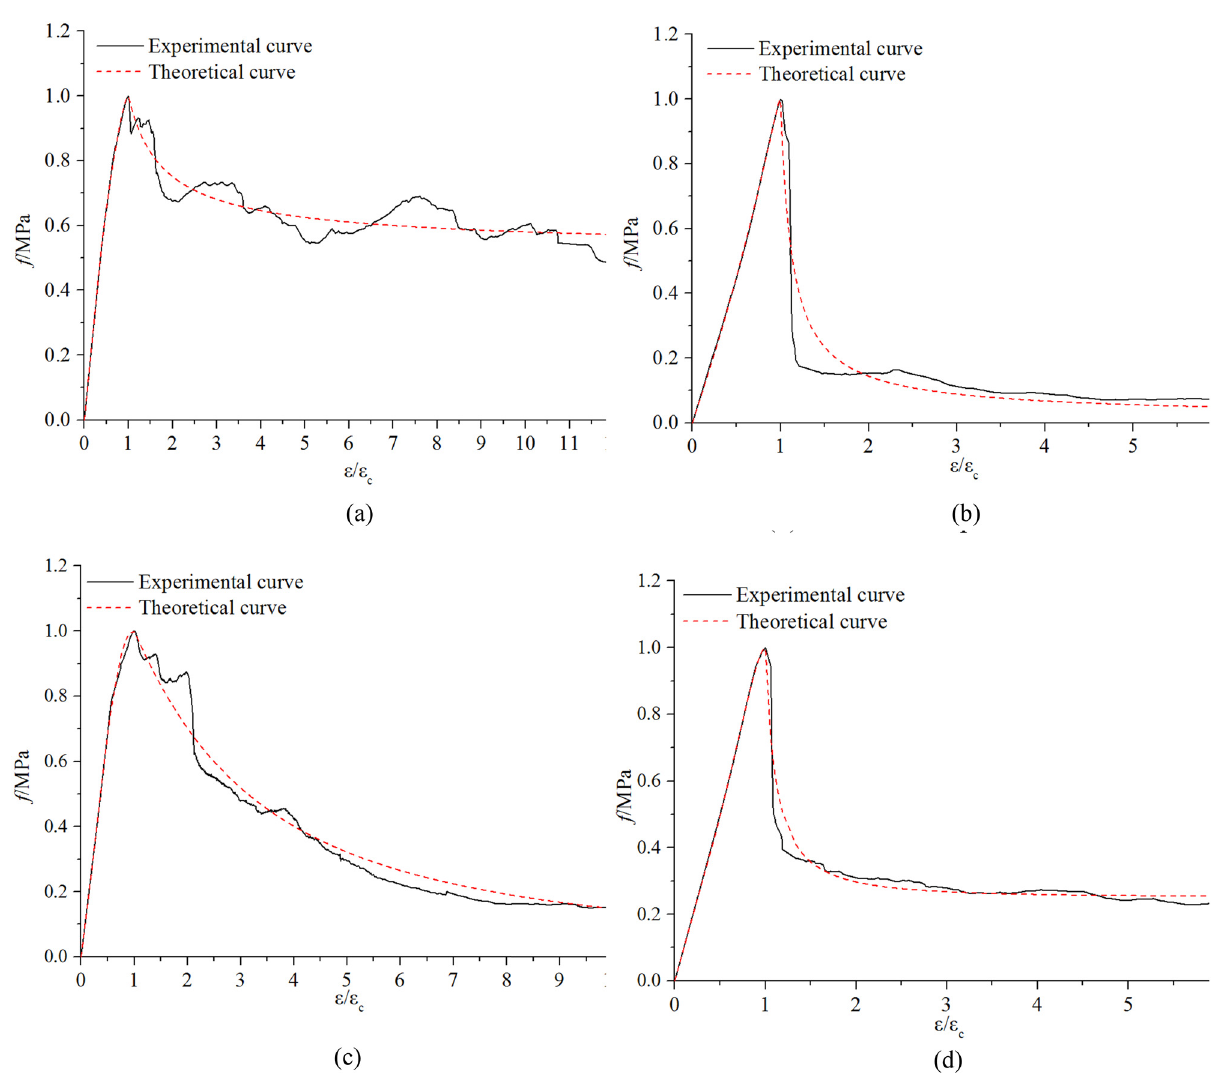
Figure 19: Comparison between theoretical curves and experimental curves: ( a ) group Y test piece, ( b ) group M test piece, ( c ) group U test piece, and ( d ) group W test